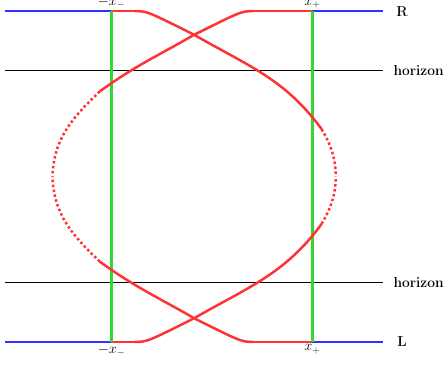
(cid:24) (cid:6) (cid:24) (cid:6) ( t P ). In this (cid:20) (cid:20)